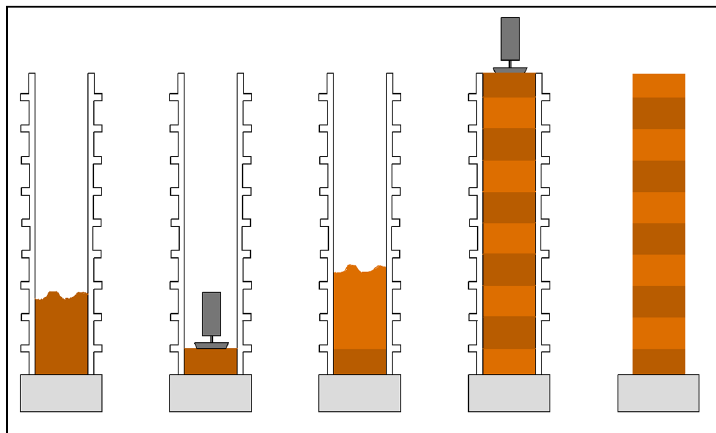
Figure 1. A scheme for erecting a wall using rammed earth technology.